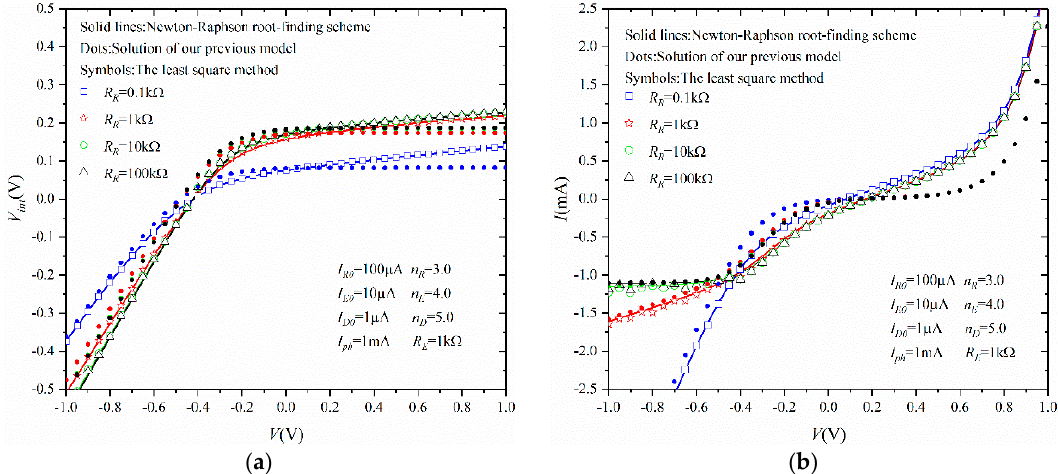
Figure 4. ( a ) V int ( V ) and ( b ) I ( V ) of the circuit in Figure 2 for different R R .